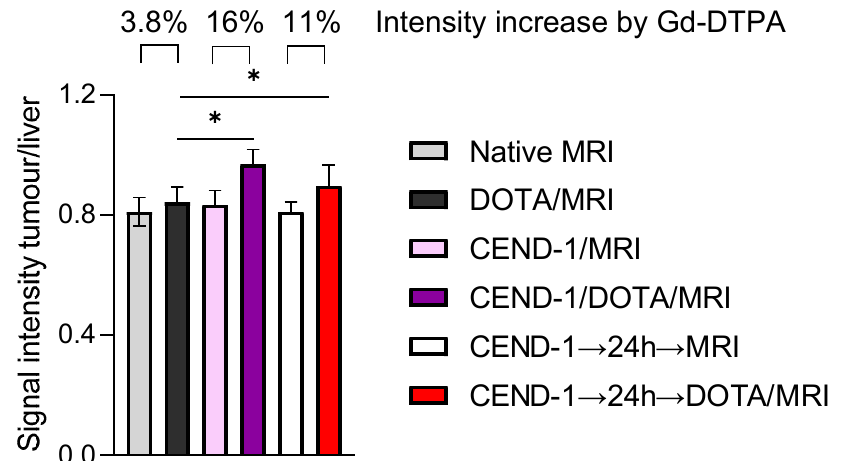
Figure 6. CEND-1 elicited a prolonged increase in tumour penetrability in HepG2 HCC mice as detected by the effect of CEND-1 on contrast agent accumulation in the HCCs. Nude mice with HepG2 tumours received DOTA-enhanced MRI before and after the injection of CEND-1. After 24 h, another DOTA-enhanced MRI was performed. Bars represent mean ± SD; asterisks indicate signi fi cant di ff erences (paired T-test). * p < 0.05. n = 8 per group.